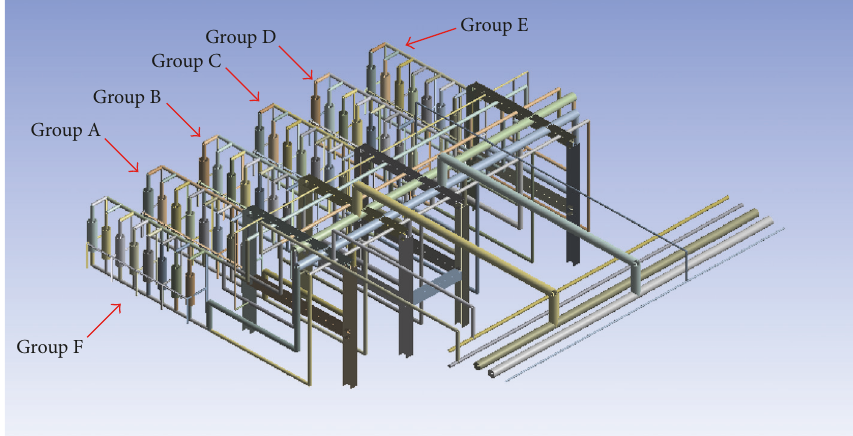
Figure 5: A complete filter and piping